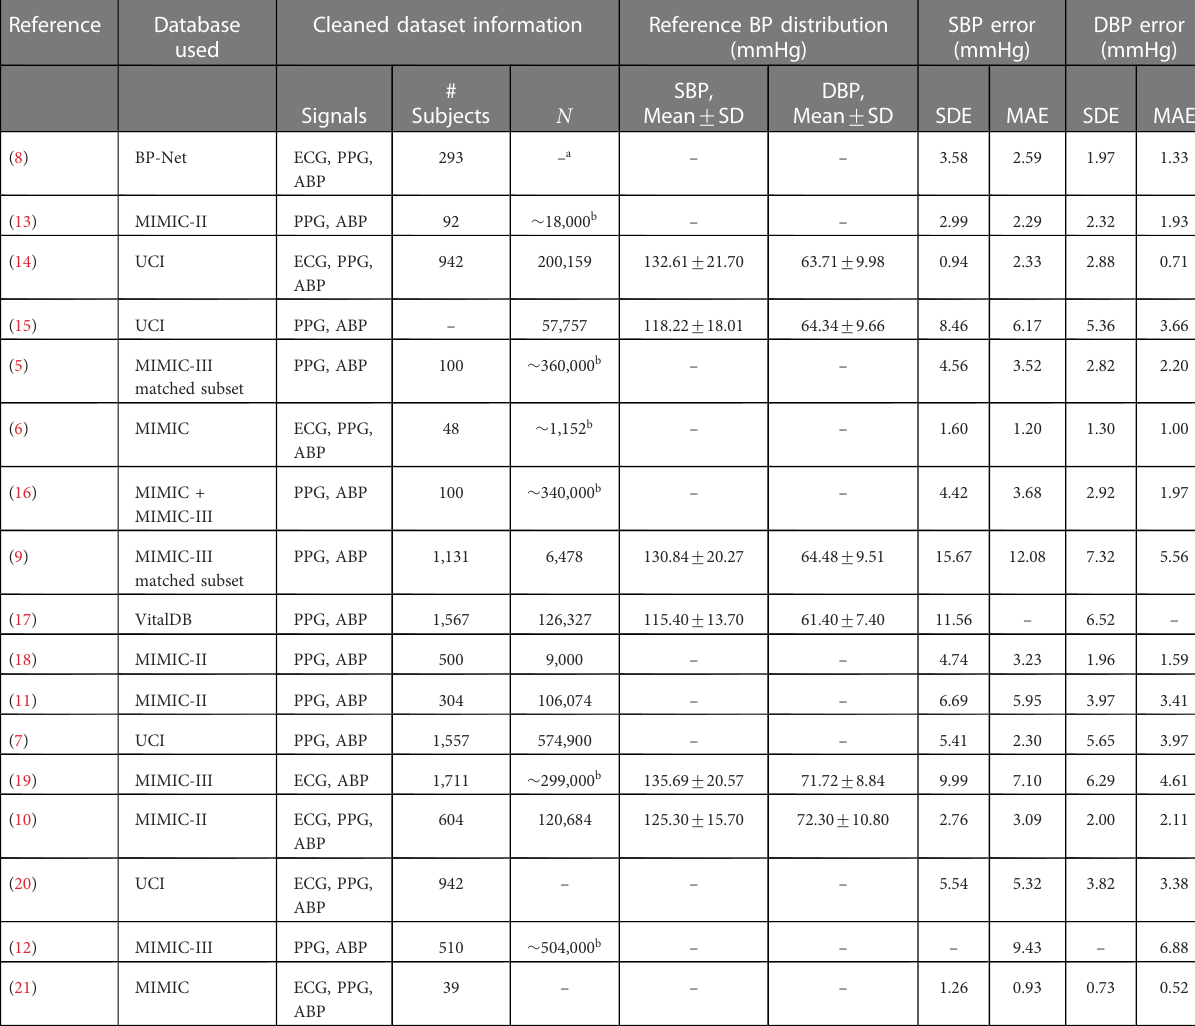
TABLE 1 Summary of data and BP estimation accuracy information in 17 recent deep learning-based cuff-less blood pressure estimation studies. The error metrics represent the optimal reported testing